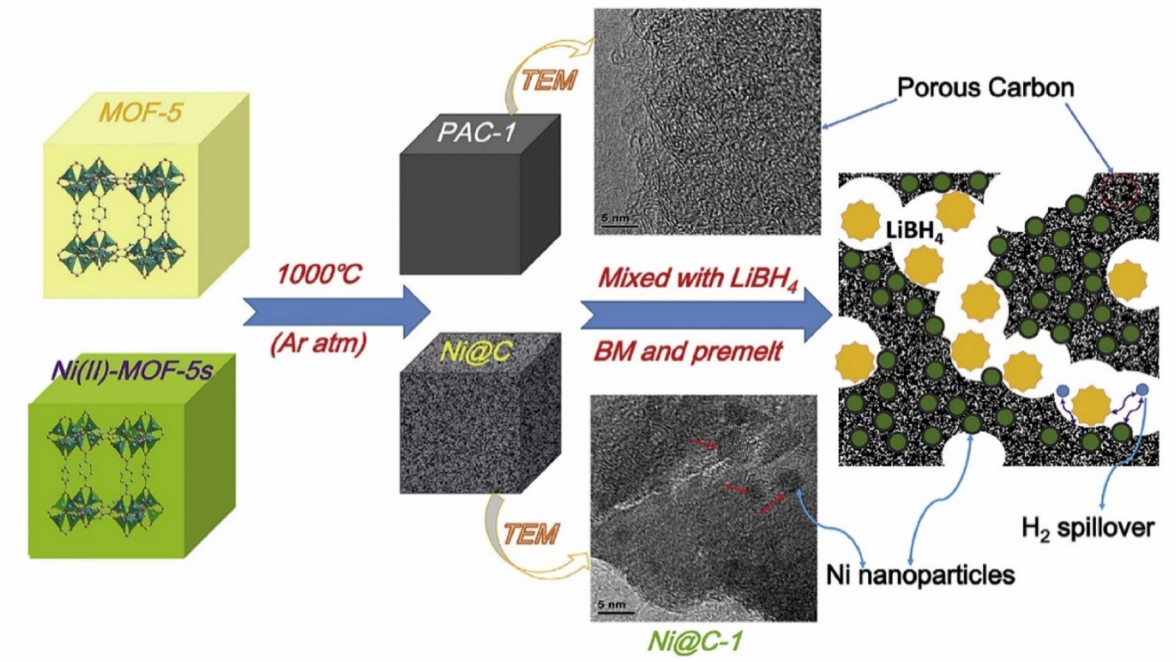
Figure 9. The schematic illustration of the products derived from MOF-5 and Ni(II)-MOF-5s and application in LiBH 4 hydrogen release [95]. (Reprinted with permission from